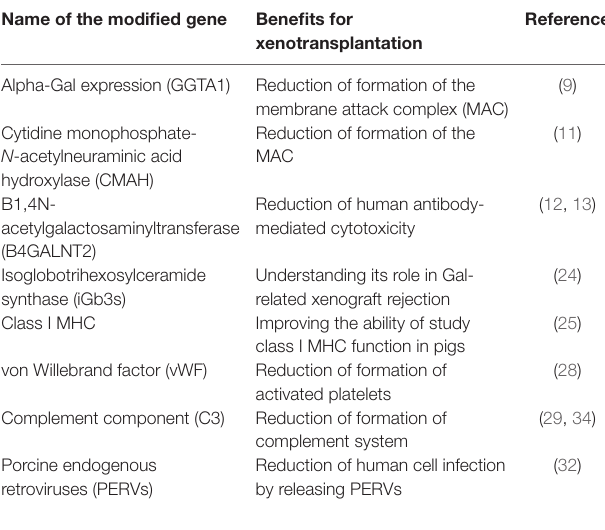
TABLe 1 | Clustered regularly interspaced short palindromic repeats/Cas9 modified genes and their benefits for xenotransplantation. name of the modified